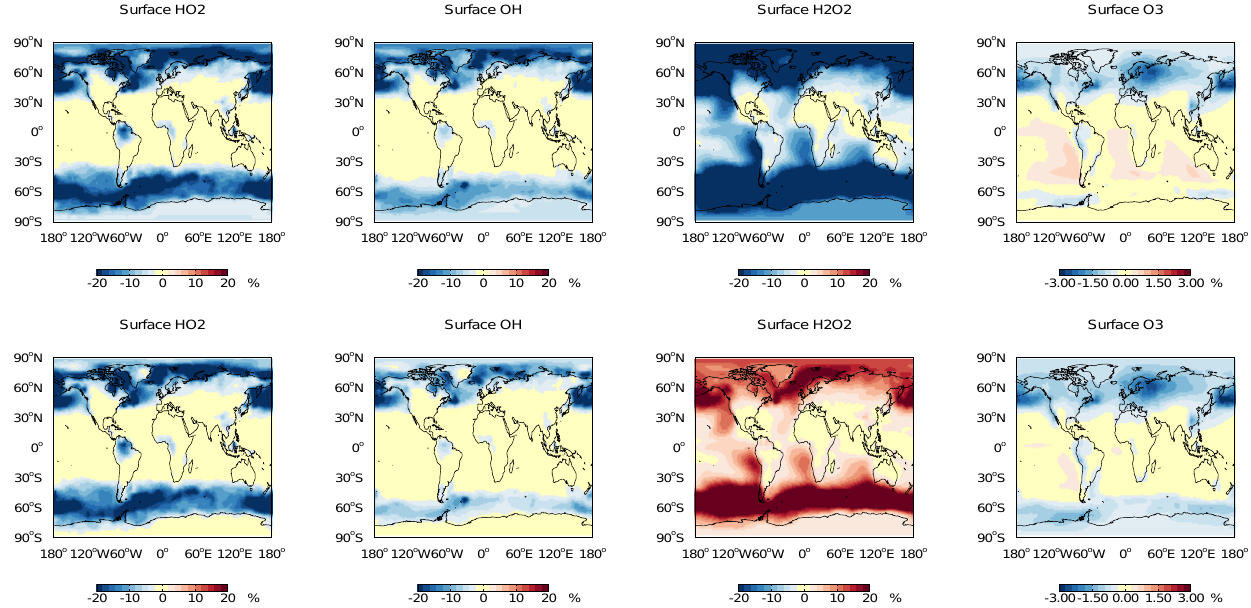
Figure 10. Annually averaged fractional change in surface HO 2 , OH, H 2 O 2 and O 3 with the inclusion of HO 2 uptake into clouds leading to: (top) the production of H 2 O and (bottom) the production of H 2 O 2 assuming a cloud pH of 5 and the Thornton et al. (2008) parameterisation.